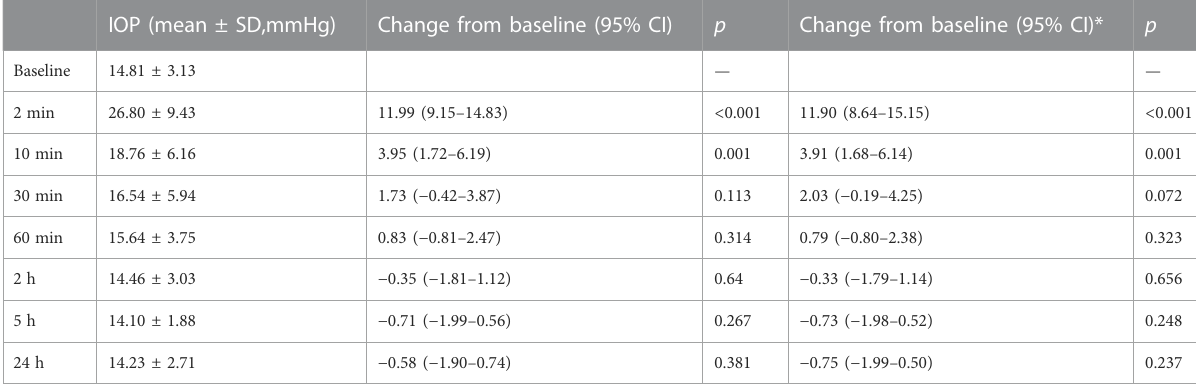
TABLE 2 Changes of intraocular pressure after intravitreal injection and comparison between each time point.